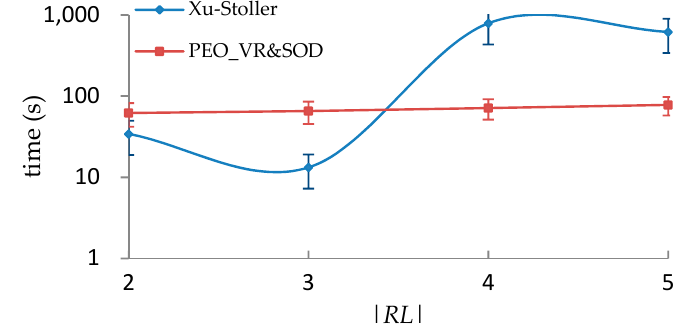
Figure 7. Comparison of time with Xu-Stoller for different | RL | values.